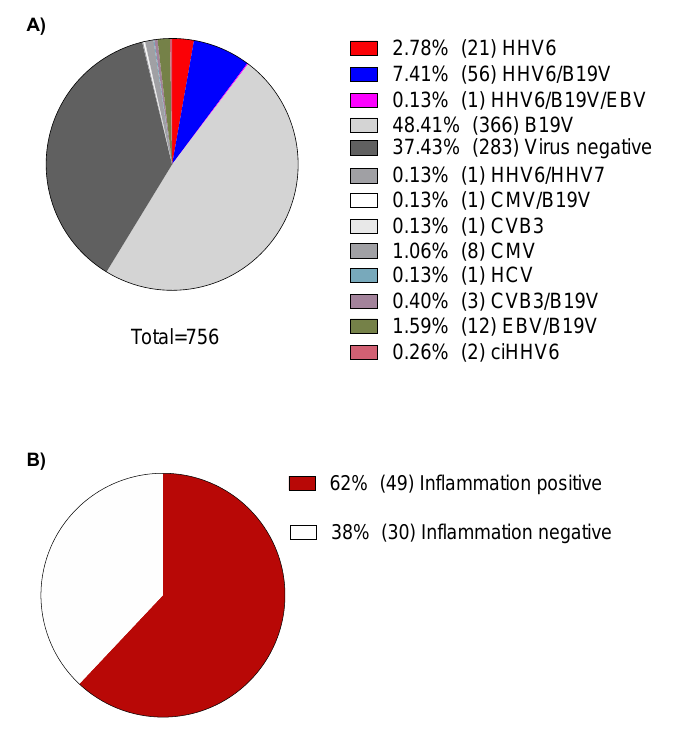
Figure 2. Distribution of viral genomes in endomyocardial biopsies of 756 consecutive patients clinically suspected of inflammatory cardiomyopathy or acute myocarditis. ( A ) Pie chart representing the proportions of cardiotropic virus-genomes. ( B ) Pie chart representing the occurrence of myocardial inflammation among 79 HHV6 DNA-positive patients, excluding ciHHV6. Percentages and ab-